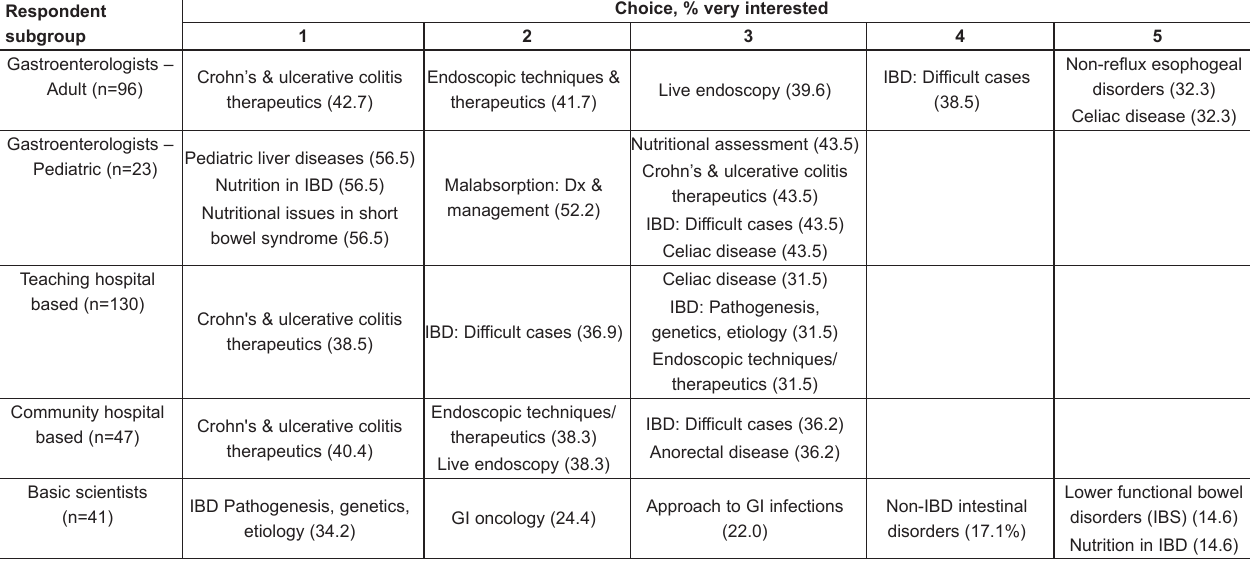
TAble 1 Most popular educational topics according to respondent